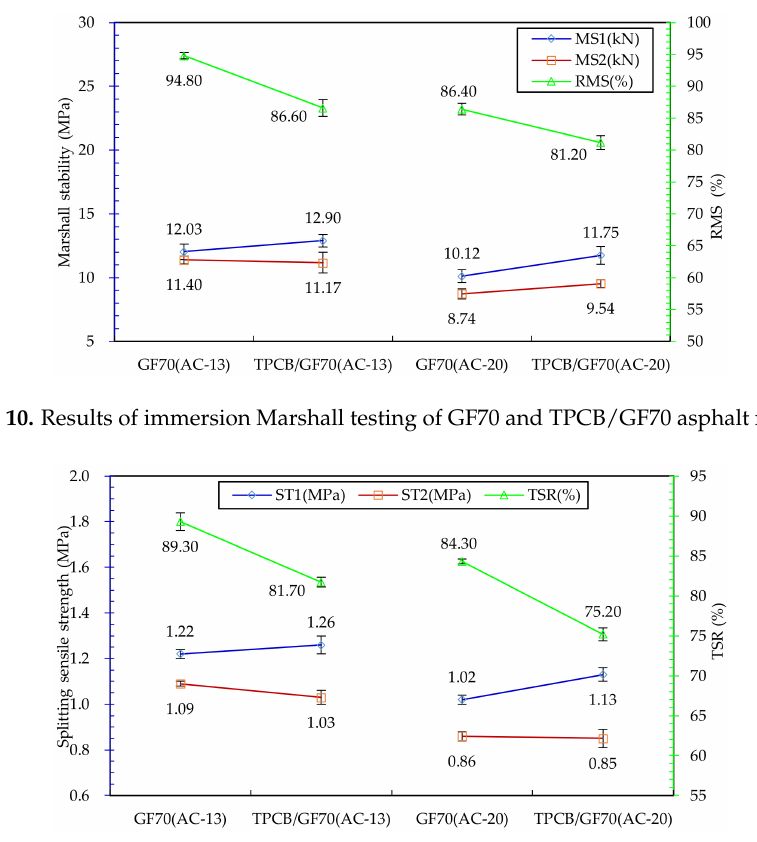
Figure 11. Results of freeze–thaw splitting testing of GF70 and TPCB/GF70 asphalt